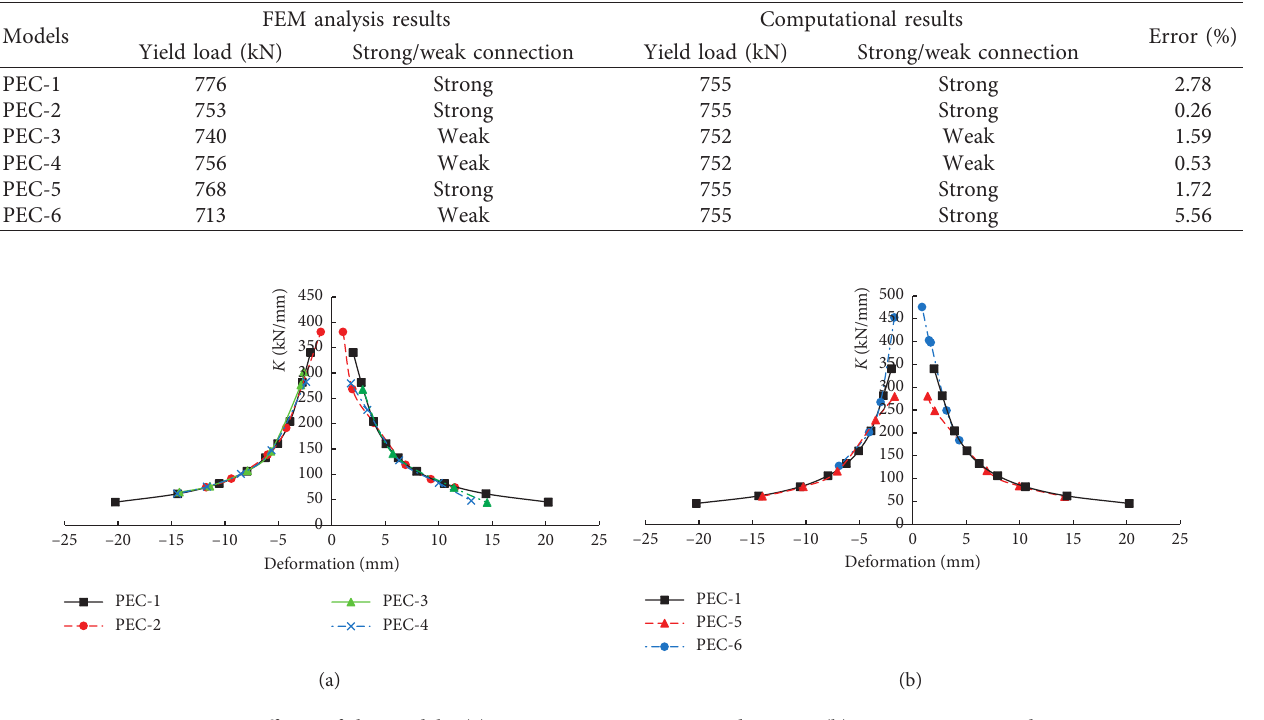
Table 2: Comparison of yield load.